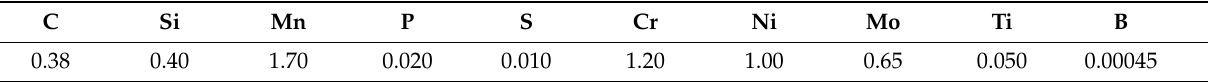
Table 2. Chemical composition of NM500 (mass fraction) %.